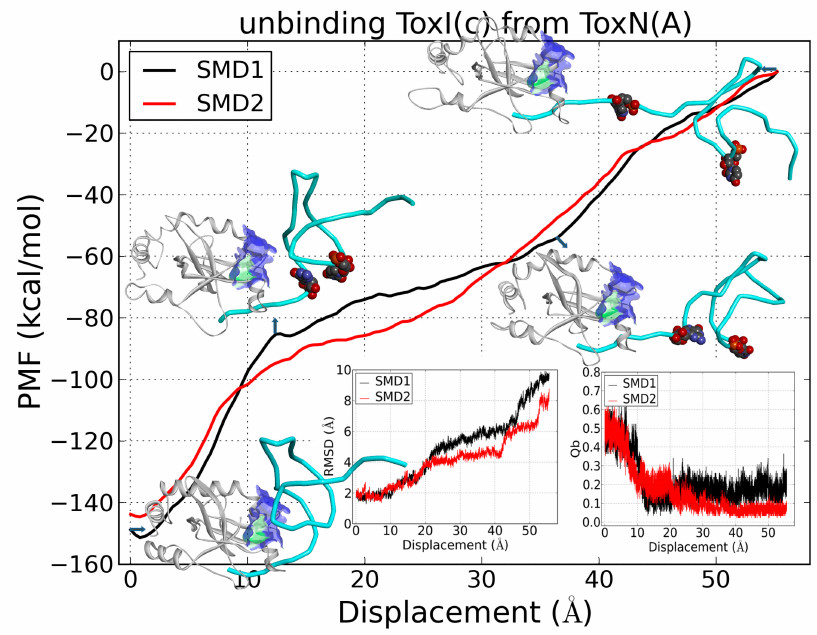
Figure 9. PMF curves of the unbinding of ToxI(c) from ToxN(A) in two SMD simulations. Insets: the Qb between ToxN and ToxI and RMSD of ToxI(c) as a function of displacements, the key structures of SMD1 from trajectories are shown. The structures of ToxN(A) are shown in white color with new cartoon representation, as well as ToxI(c) in cyan with tubes representation. A section of the interacting surfaces is shown. Nucleotides U9 and G26 are shown in ball representation.